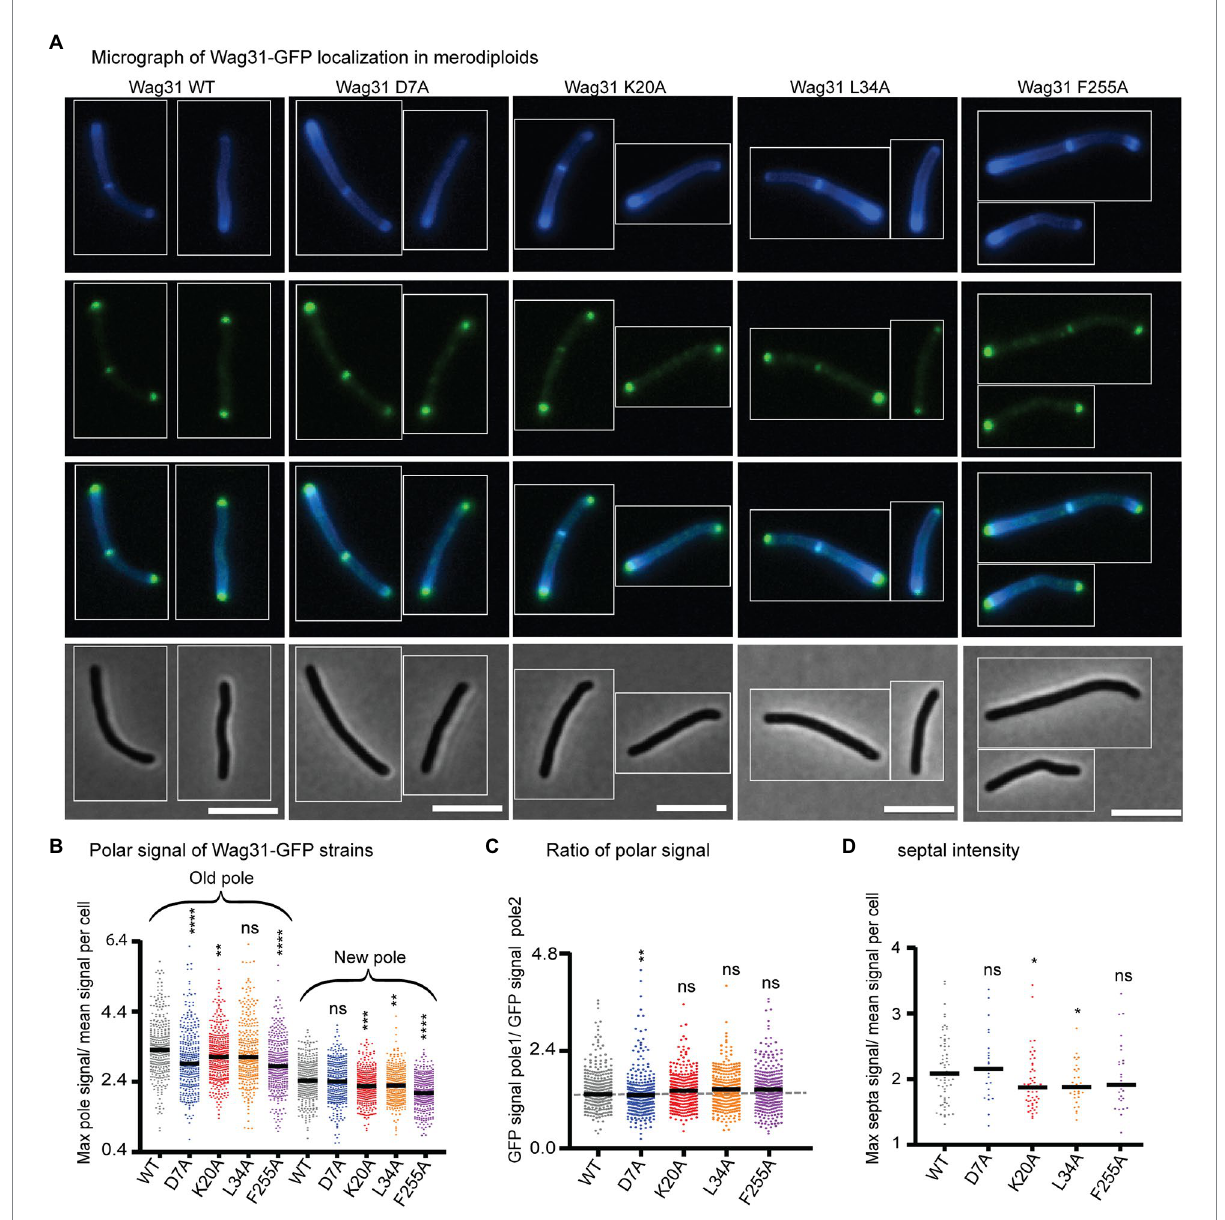
FIGURE 2 Wag31 mutant proteins localize normally in merodiploid strains. (A) Micrographs of WT Msmeg expressing Wag31-GFPmut3 constructs with the indicated mutations. Top: HADA; second: GFP; third: merged; bottom: phase. The scale bar is 5 microns, and it applies to all images. (B) Relative polar intensity of GFPmut3 signal from cells in A. (C) Ratio of normalized signal at the old pole over normalized signal at the new pole, from B. (D) Relative septal intensity of GFPmut3 signal from cells in A. ns, p > 0.05, * p = <0.05, ** p = <0.005, *** p = <0.0005, **** p = <0.0001. All p-values (B) , (C) were calculated by one-way ANOVA, Dunnett’s multiple comparisons test and the p -values (D) were calculated by the Welch’s t